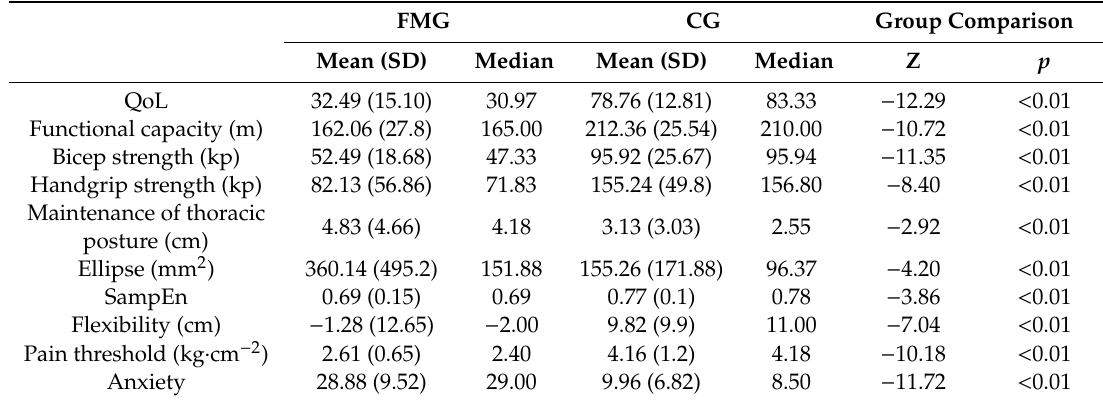
Table 1. Results of the comparison between women with fibromyalgia and their healthy counterparts.